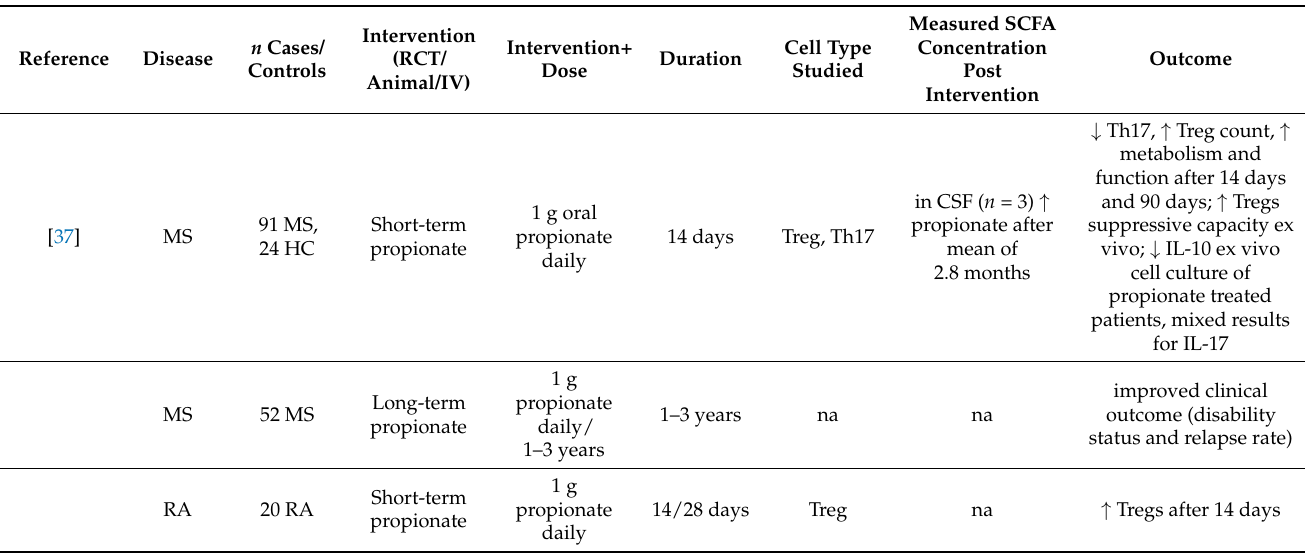
Table 4. Interventions with short chain fatty acids in human patients with autoimmune disease assessing changes in T